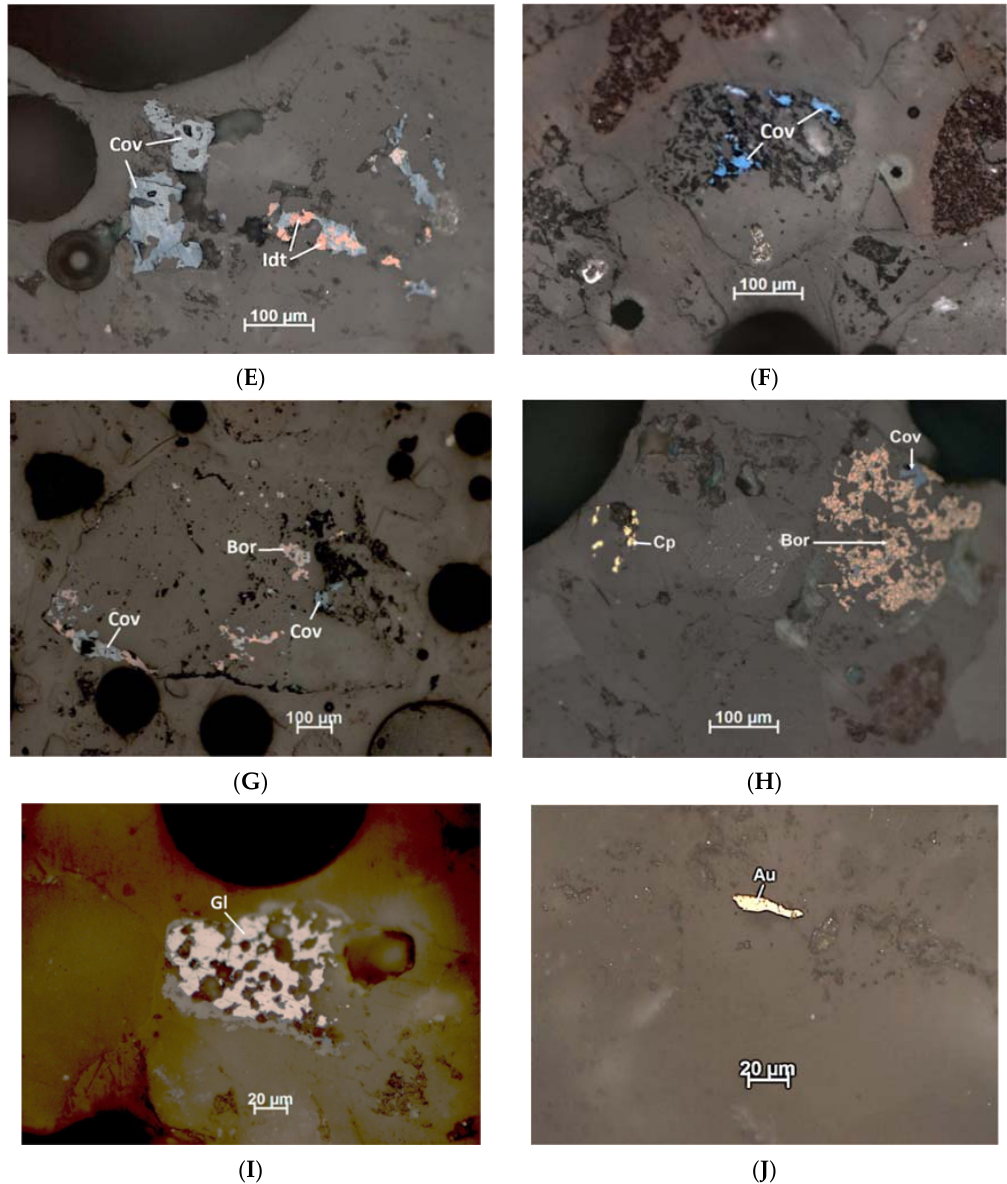
Figure 5. Examples of ore minerals from Osnovnoe sediments in microphotography, ( A ) chalcopyrite (Ccp) grains in quartz; ( B ) chalcopyrite (Ccp) along the edge of a quartz grain; ( C ) chalcocite (Cc) in intergrowth with quartz, 2/5; ( D ) Bornite (Bor) in intergrowth with chalcocite (Cc) in quartz; ( E ) covellite (Cv) in intergrowth with idaite (Idt); ( F ) covellite (Cov), Coveline (Cov) and Chalcopyrite along the edges of a quartz grain; ( G ) covellite (Cov) in intergrowth with bornite (Bor) in a quartz grain; ( H ) bornite (Bor)–covellite (Cv) intergrowths and chalcopyrite (Cp) in quartz grain ( I ) accumulation of galena (Gl) grains; ( J ) gold (Au) as native gold inclusion; 1 polarizer, reflected light.